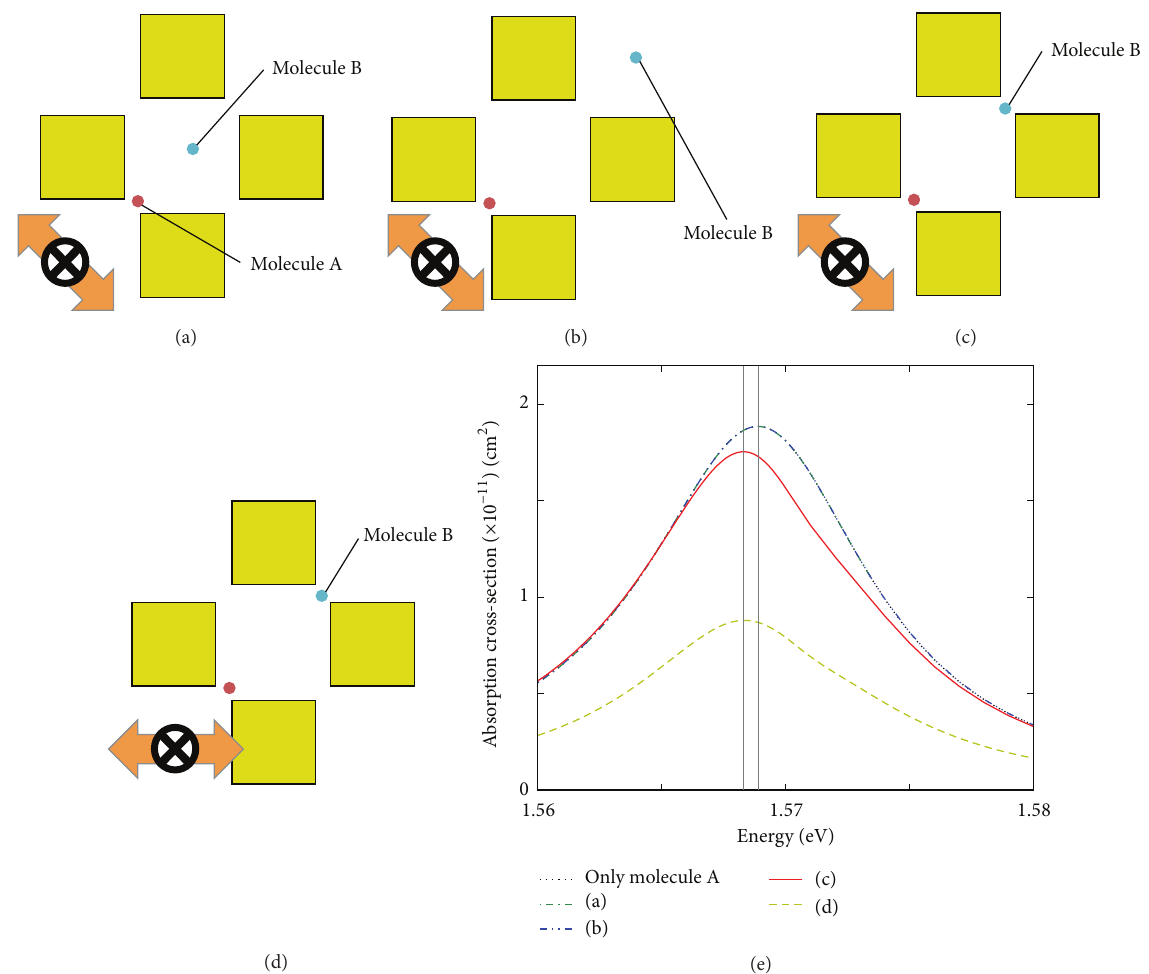
Figure 2: (a–d) Top view of the position of two molecules and metal blocks: the polarization direction of the incident field is represented by two-way orange arrow. (a–c) One of the molecules is fixed (red circle), while the other one (blue circle) is placed in different positions. (d) We alter the polarization direction in the same configuration as (c). (e) Absorption cross-section of the molecule (red circle) is plotted against the incident field energy for different arrangement of molecules. The black dotted line represents the absorption for the case where only one molecule (red circle) exists. One can see the large peak shift ( ∼ 0.6meV) due to the intermolecule interaction, only when both of the molecules are located in the hot spots (c,